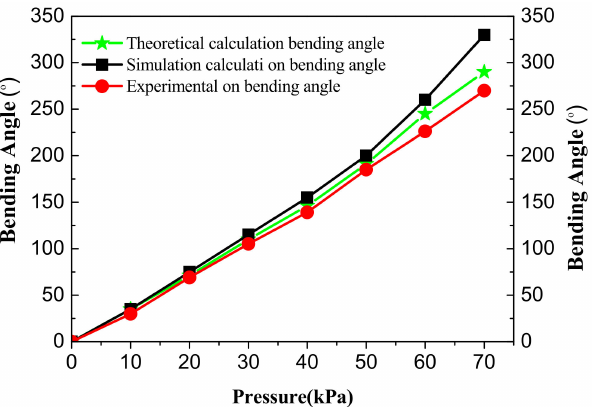
Figure 17. Comparison of theoretical calculation, simulation calculation, and experimental results.